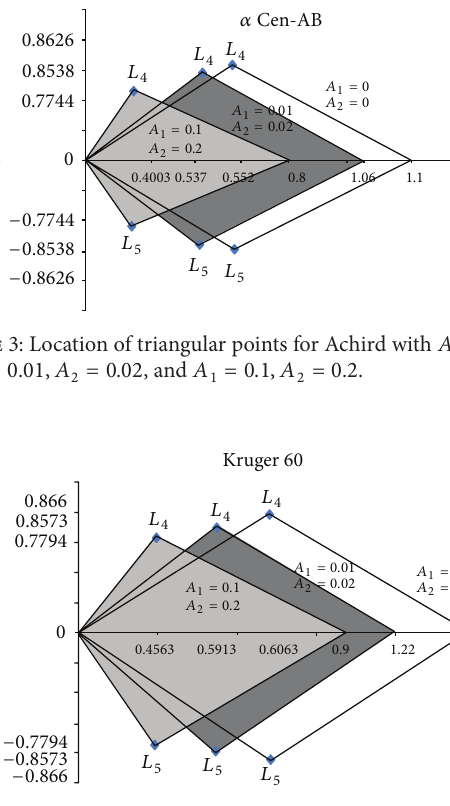
Figure 4: Location of triangular points for Kruger 60 with 𝐴 1 = = 0 , 𝐴 = 0.01 , 𝐴 = 0.02 , and 𝐴 𝐴 2 1 2